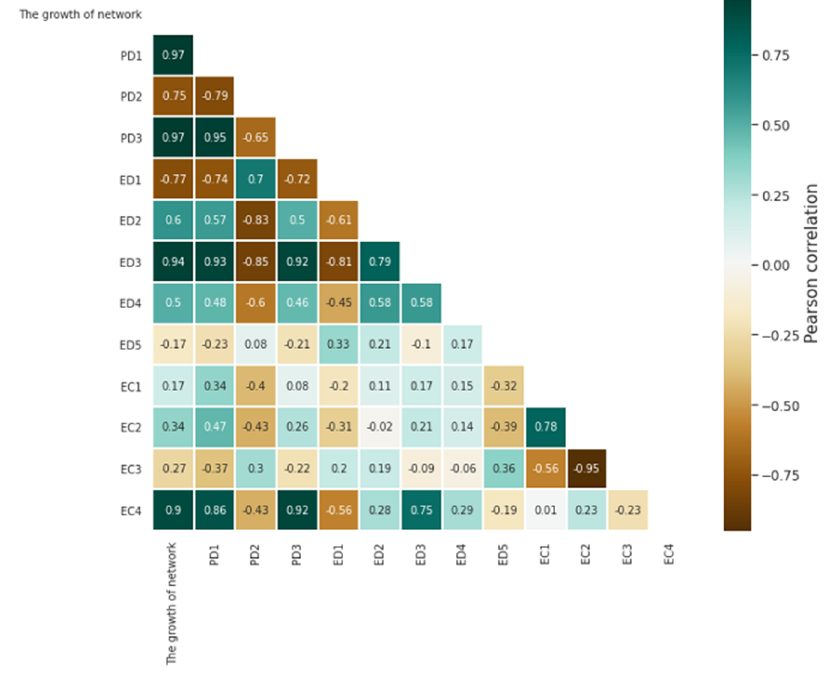
Figure 4. The PCC’s outcome of the SNCF network.